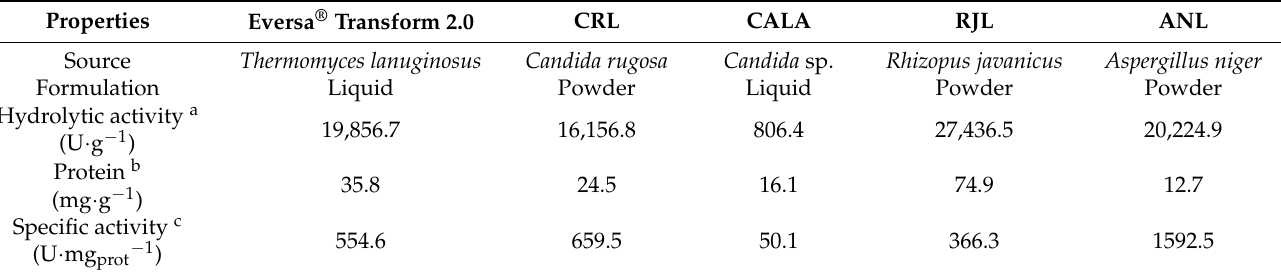
Table 3. Properties of microbial lipases used in this